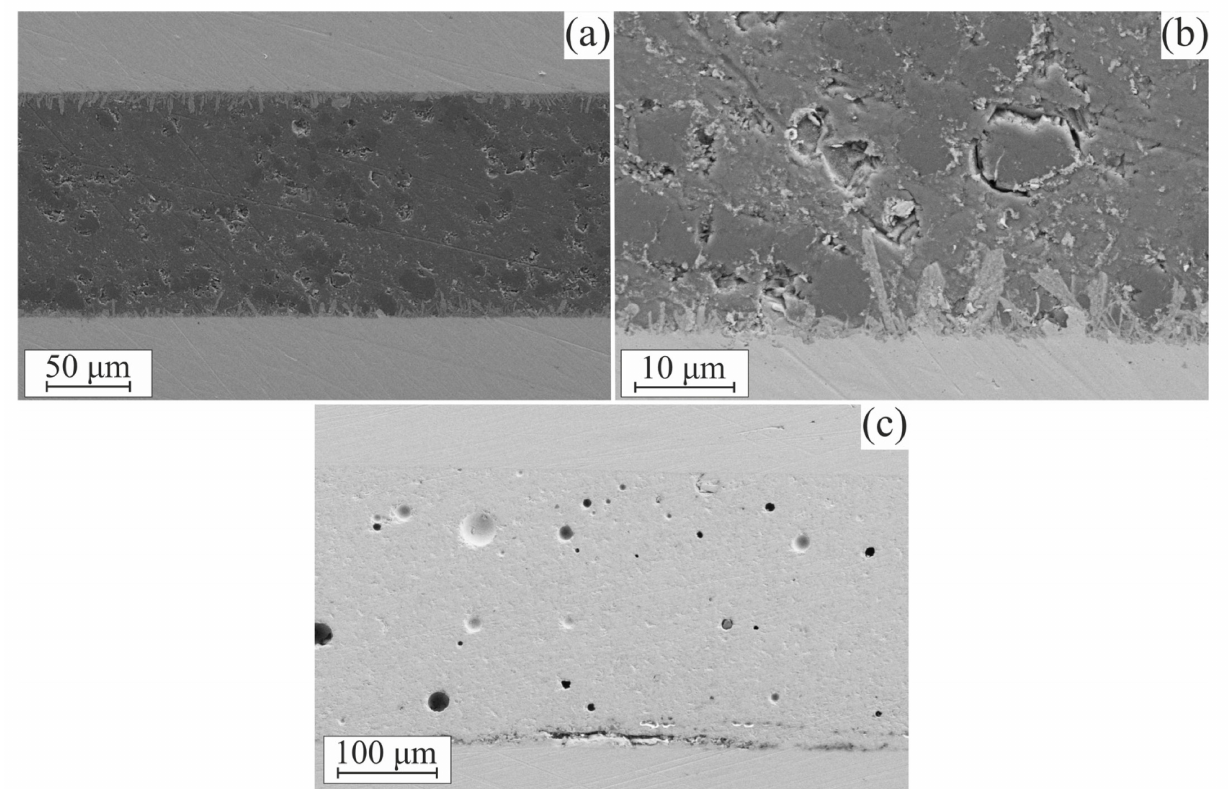
Figure 6. SEM images of the cross-sections of sealant–steel assembly: ( a ) CaO-SiO 2 -B 2 O 3 sealant, ( b ) close-up image of CaO-SiO 2 -B 2 O 3 sealant–steel interface, and ( c ) Schott 394